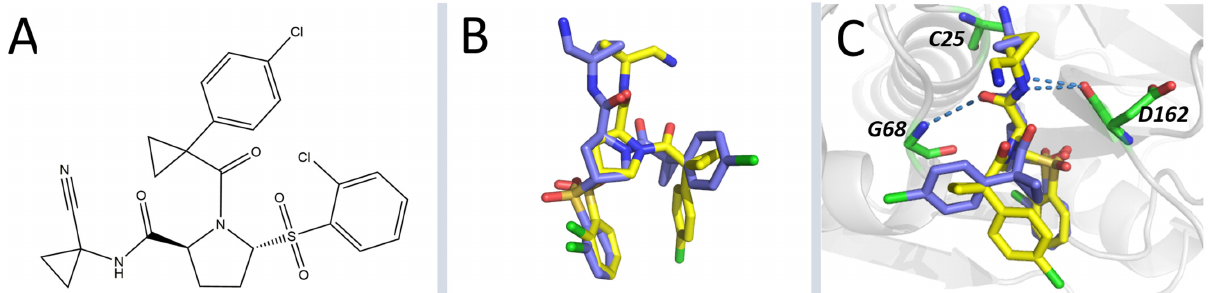
Fig 2. Nitrile re-docking into the substrate-binding site of HuCatL. (A) Nitrile chemical structure. (B) Superposition of nitrile best-re-docked pose (yellow) and crystal structure (blue) (RMSD = 3.4 Å ). (C) Hydrogen bonds between the residues of HuCatL binding site and nitrile in both the crystal (blue) and the best re-docked (yellow) complex structures. Hydrogen bonds are shown as blue dotted lines, and HuCatL interacting residues (green) are depicted as sticks. Note that nitrile re-docking only takes into account its non-covalent interactions with the enzyme, therefore, it was treated as a non-covalent ligand.